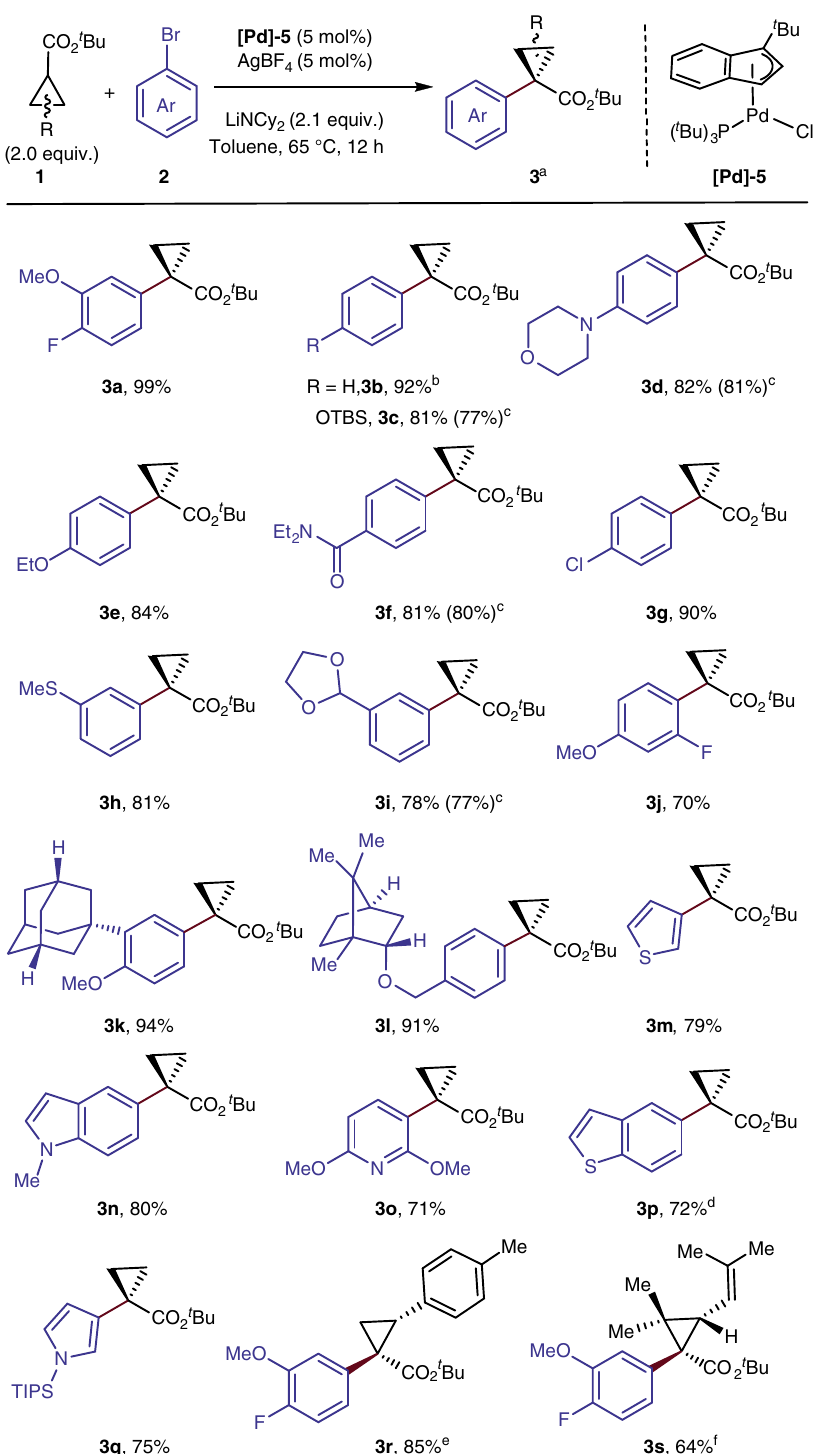
Fig. 2 Scope of α -arylation of cyclopropyl t -butyl esters. a Isolated yields, dr was determined by crude 19 F NMR. b With PhCl or PhOTf used instead of PhBr, no product was observed; with PhI used instead, 64% yield. c Yield in the parentheses in 10 min. d 7 mol% [Pd] cat and AgBF 4 were used. e 50 ° C, dr 12:1, major isomer is shown. f Major isomer is shown; dr = 2:1. TIPS: